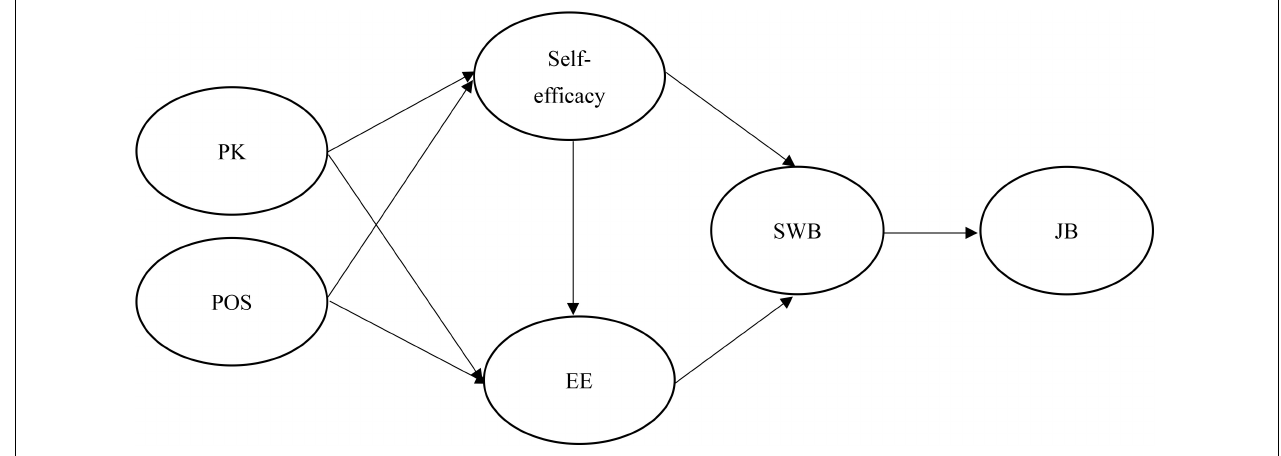
FIGURE 1 | Research